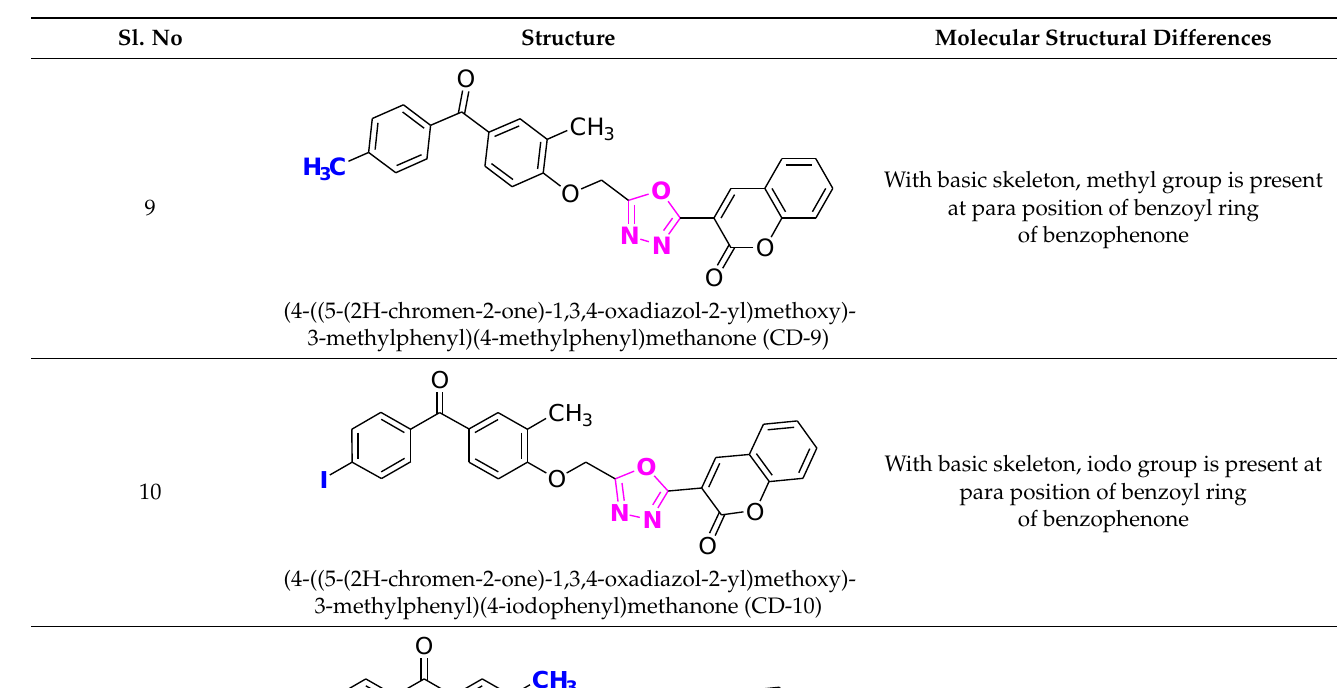
(4-((5-(2H-chromen-2-one)-1,3,4-oxadiazol-2-yl)methoxy)- 3-methylphenyl)(4-iodophenyl)methanone (CD-10)